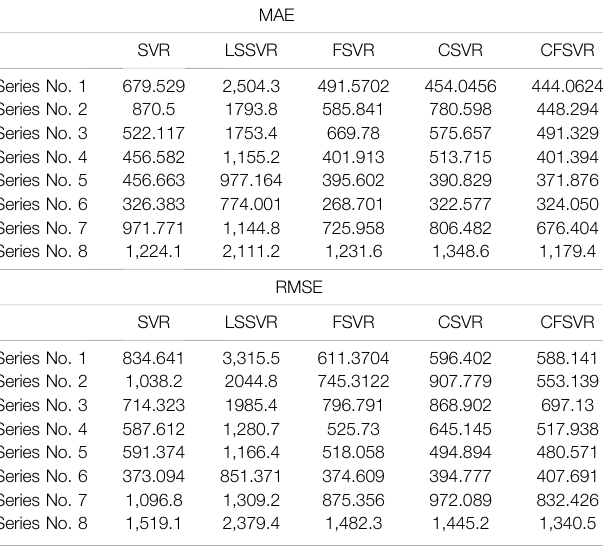
TABLE 6 | Result of NN3 time series by CFSVR, CSVR, SVR, LSSVR, FSVR.